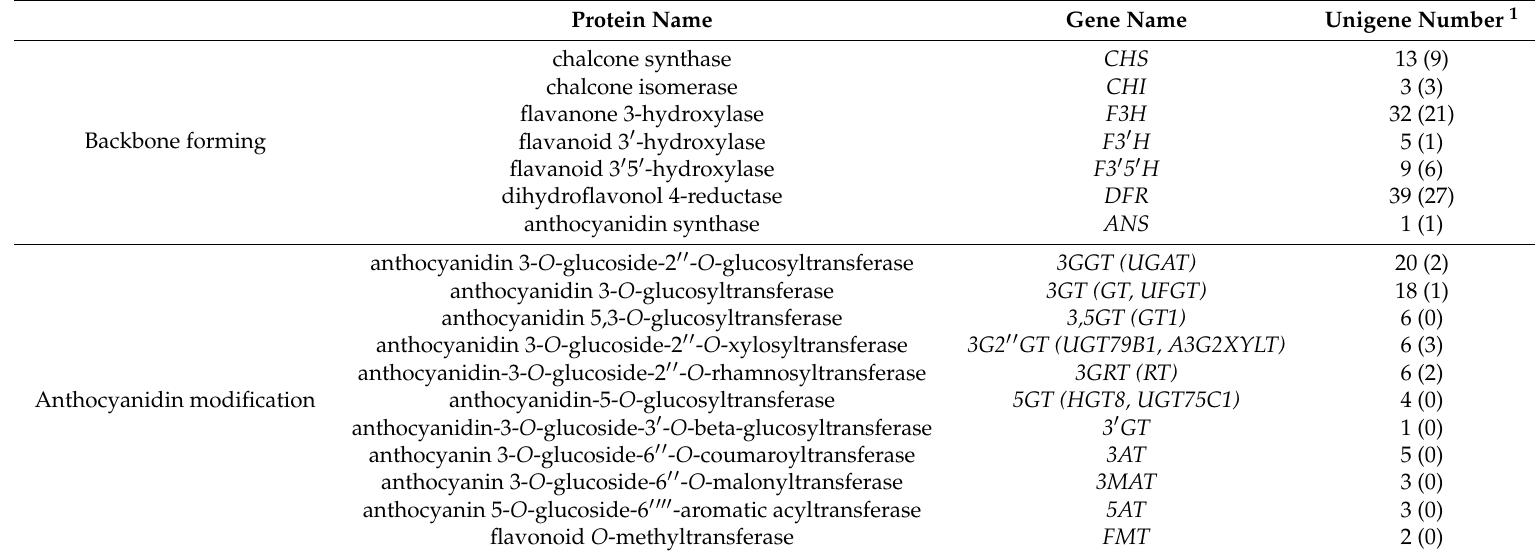
Table 2. Enzyme-encoding genes involved in anthocyanin biosynthesis of Ranunculus asiaticus L.